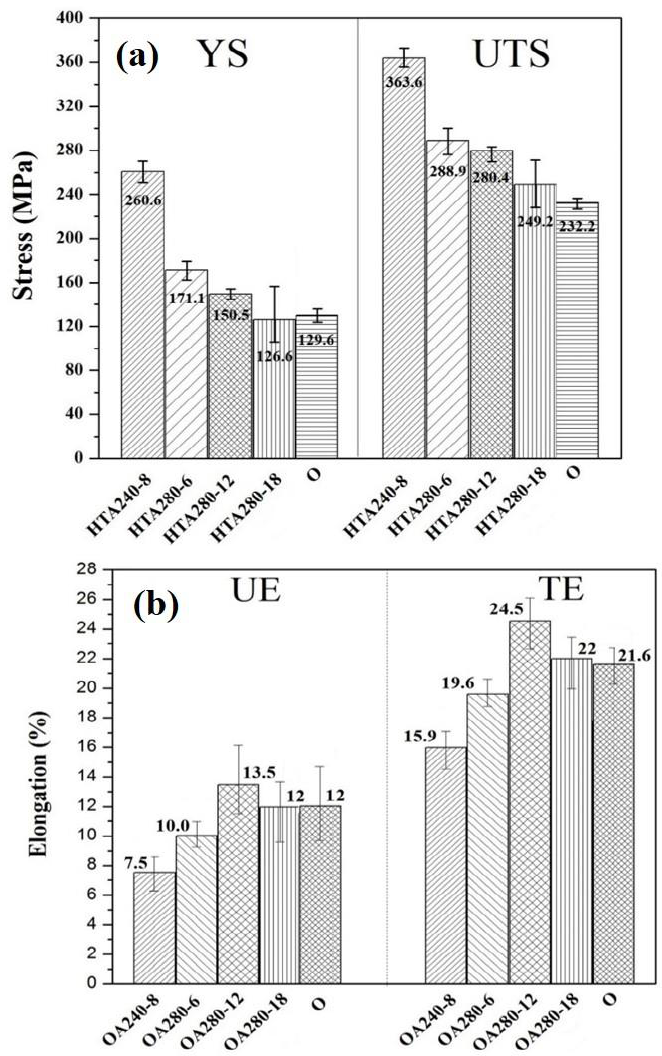
Figure 10. Tensile properties of 7075 Al alloy extruded rod after various PPHTs: ( a ) strength; ( b ) elongation.